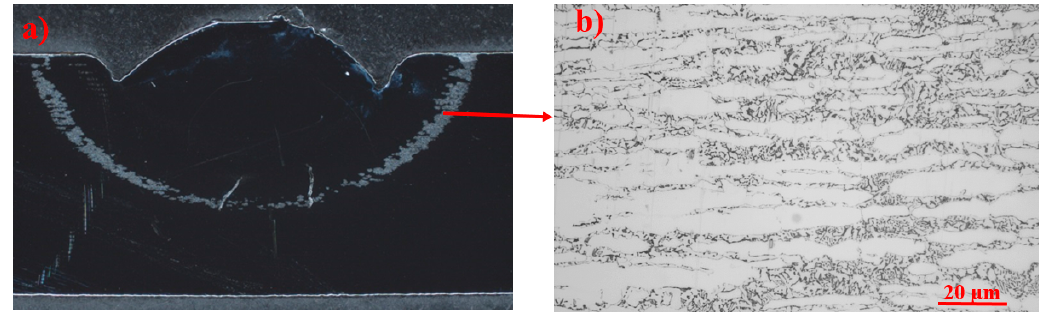
Figure 13. ( a ) Cross-section of the specimen after testing in 1 M NaCl at 700 mV SCE, according to ASTM G150, showing a corroded zone heat-treated at 630–750 °C. ( b ) Optical micrograph of the corroded region showing the attack of secondary γ 2 and δ next to the coral-shaped σ .